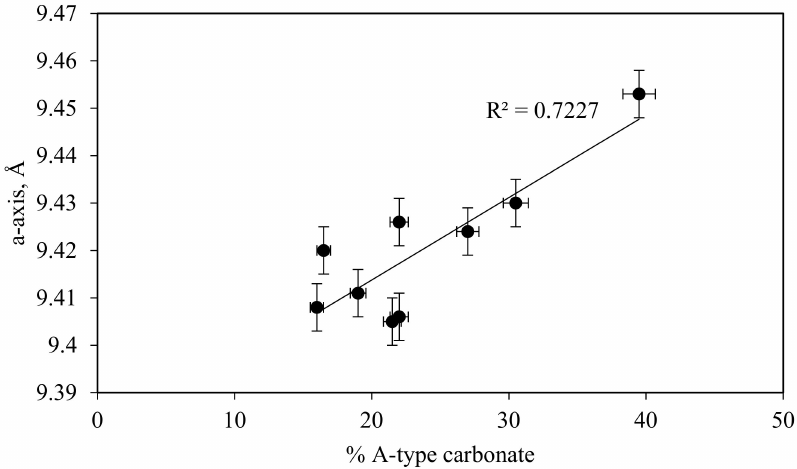
Figure 8. The correlation between the a-axial lengths of the unit cells of the apatites in Table 4 with the spectroscopically-determined percentage of A-type